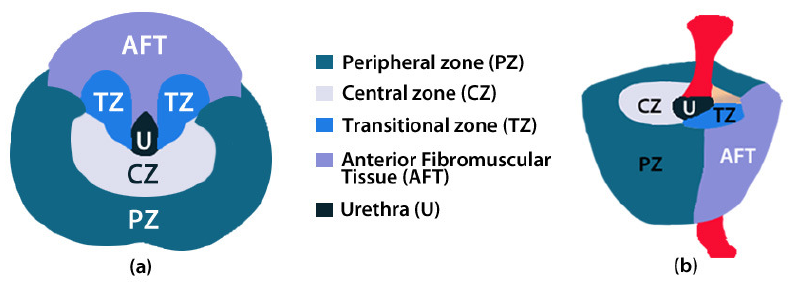
Figure 1. Anatomy of the prostate in ( a ) transversal and ( b ) sagittal planes [11].